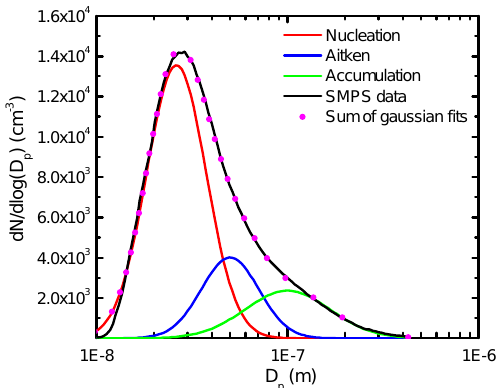
Fig. 8. Average aerosol size distribution in the RA tunnel. The SMPS sampled in total for about 16h, on the 7, 12 and 13 July 2011, mostly during daytime. The average particle number concentration was 366000cm − 3 with an average diameter of 38.7nm.